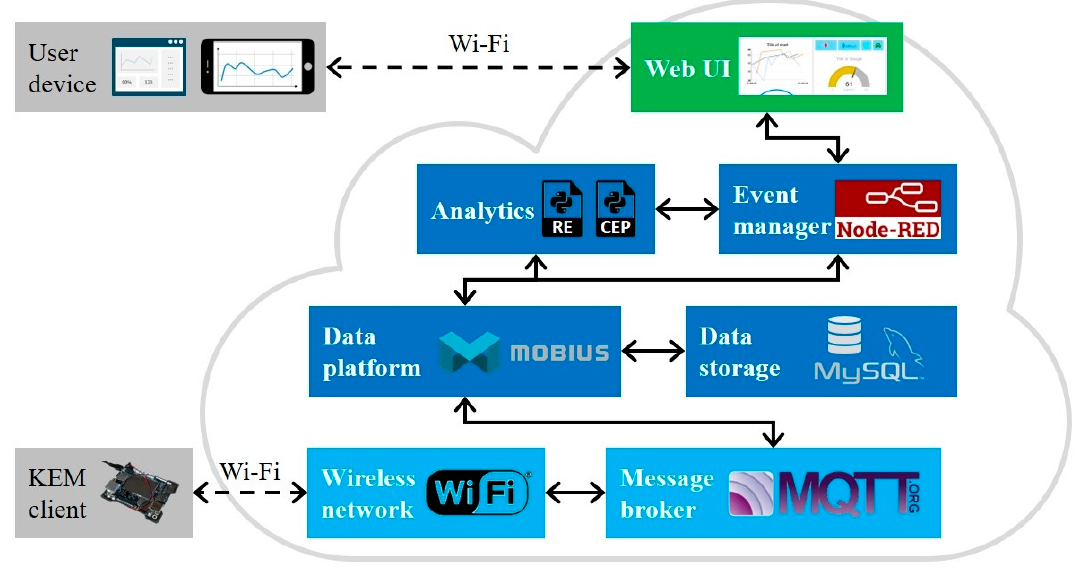
Figure 6. The architecture of the KEM server.